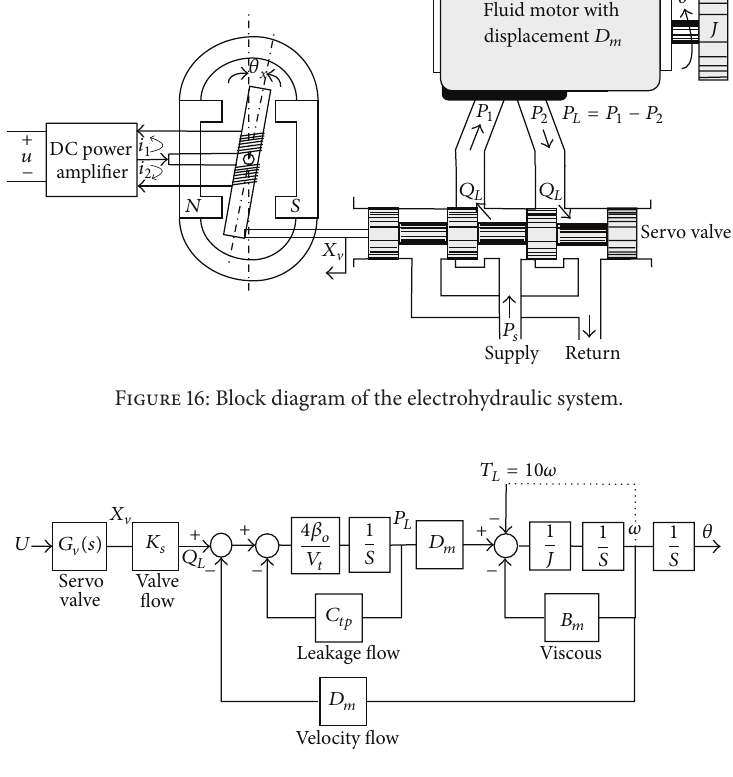
Figure 17: Mathematical model of the electrohydraulic